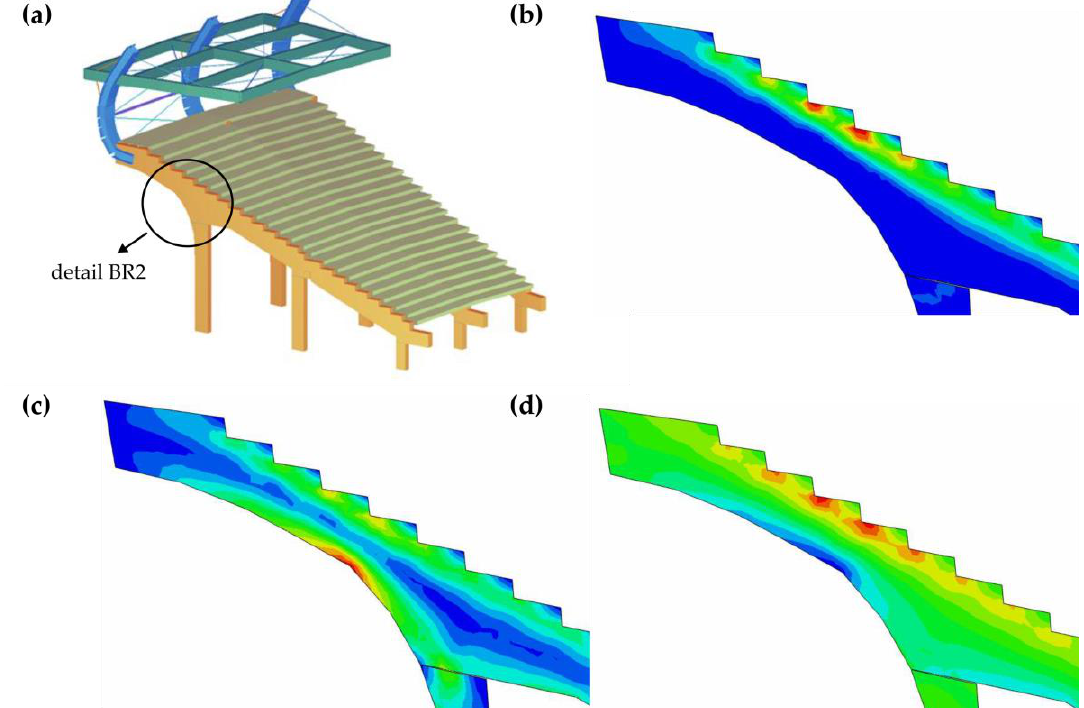
Figure 19. ( a ) Placement of the highest stress concentrations in the main girder of the stadium stand. ( b ) von Mises map of stresses in the BR2-reinforced concrete girder area (red color—maximum stress equal to 10 MPa). ( c ) Map of the main tensile stresses within the BR2-reinforced concrete girder (red color—maximum tensile stress equal to 8 MPa). ( d ) Map of the horizontal normal stress s11 within the BR2-reinforced concrete girder (red color—maximum tensile stress equal to 8 MPa, blue color—maximum compressive stress equal to 8 MPa) .